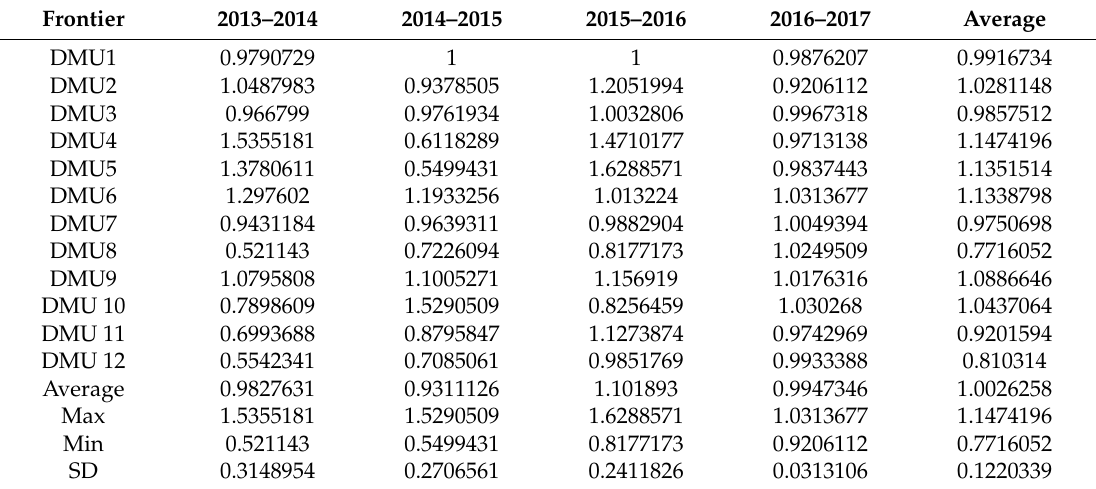
Table 8. Technical (frontier-shift) change over the period from 2013 to